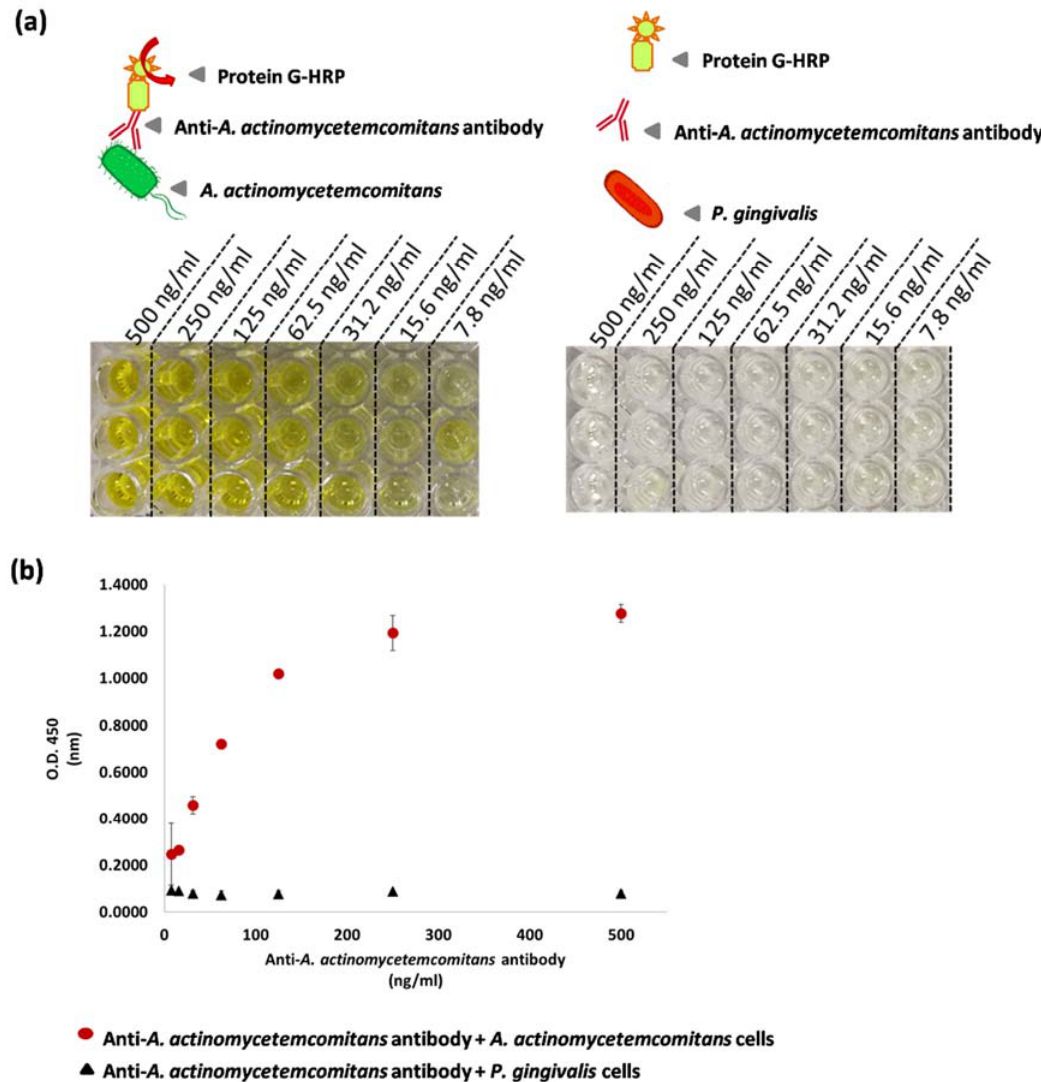
Figure 4. Specificity of Anti- A. actinomycetemcomitans antibody. Anti- A. actinomycetemcomitans antibody specifically binds to A. actinomycetemcomitans cells and not to P. gingivalis cells. ( a ) A 96-well plate of Anti- A. actinomycetemcomitans antibody and A. actinomycetemcomitans cells (left). A 96-well plate of Anti- A. actinomycetemcomitans antibody and P. gingivalis cells (right). ( b ) ELISA results when executed with different concentrations of Anti- A. actinomycetemcomitans antibody for A. actinomycetemcomitans (red). P. gingivalis cells (black) were used as negative control. Mean and SD values were obtained from three measurements.